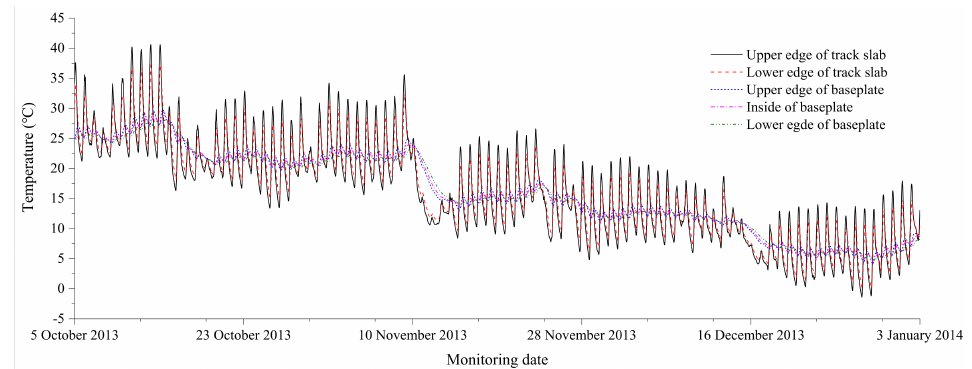
Figure 4. Temperature change at monitoring point of ballastless track (Section